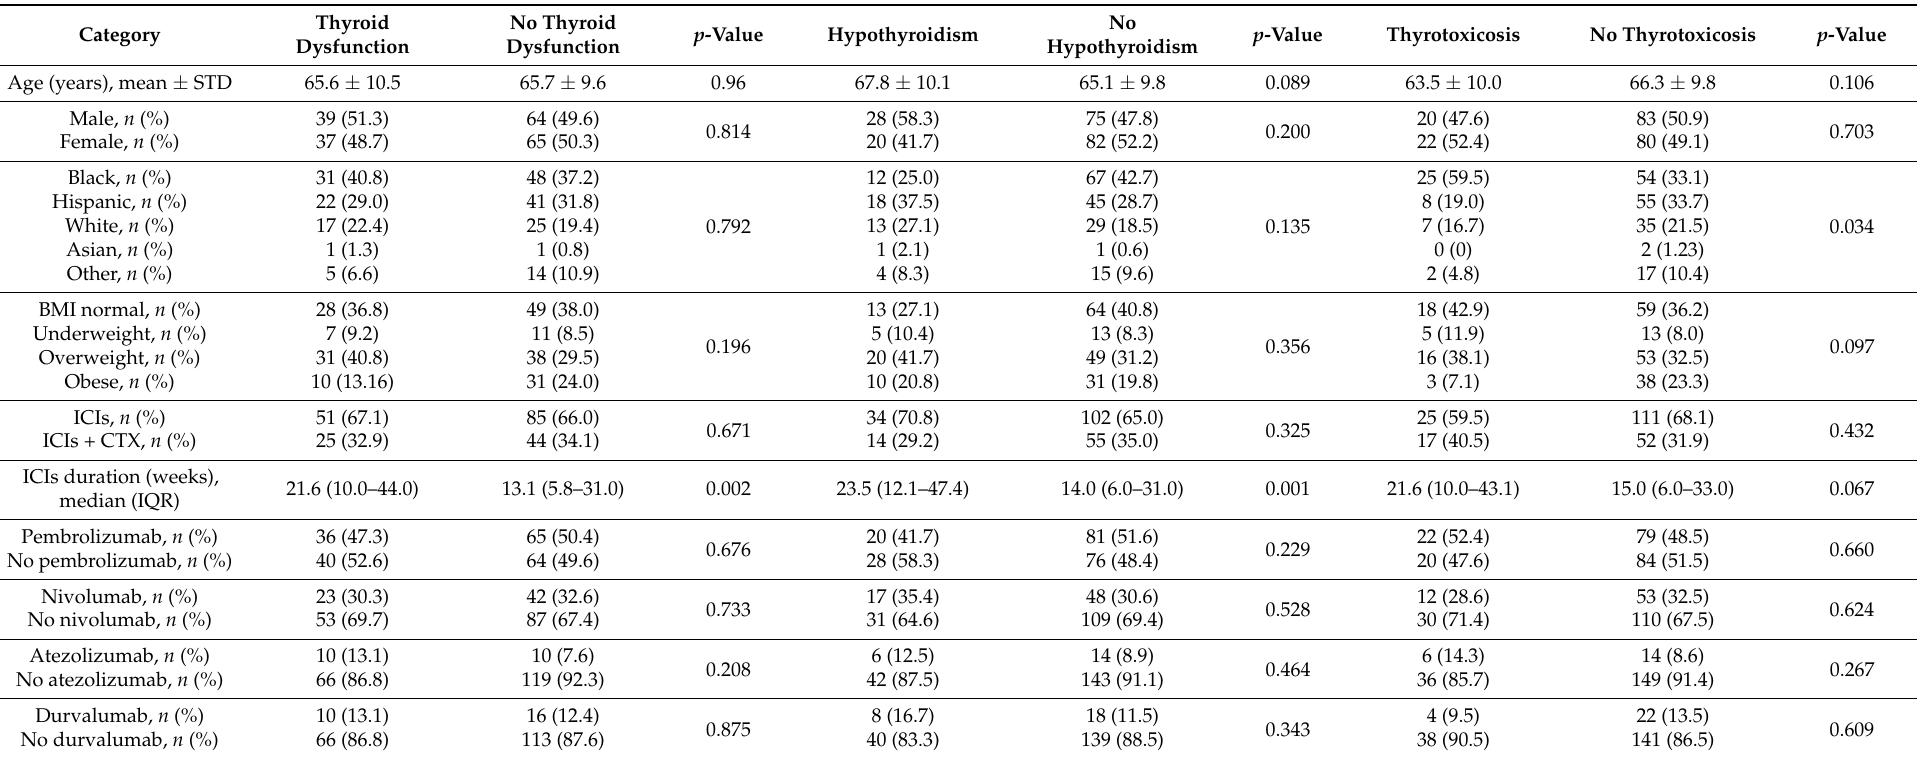
Table 2. Associations comparing characteristics between subjects with and without thyroid dysfunction, hypothyroidism, and